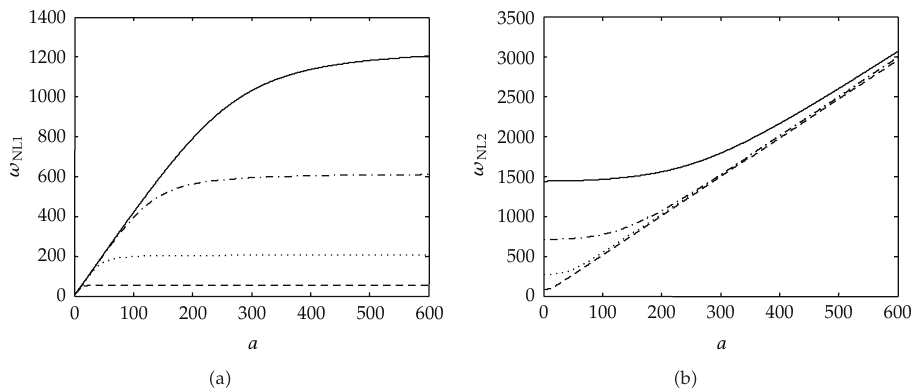
Figure 5: Nonlinear frequency versus nondimensional amplitude for di ff erent beam slenderness ratios (cid:2) - - - (cid:3) η (cid:7) 10, (cid:2) ··· (cid:3) η (cid:7) 20, (cid:2) - · - (cid:3) η (cid:7) 35, and (cid:2) — (cid:3) η (cid:7) 50.